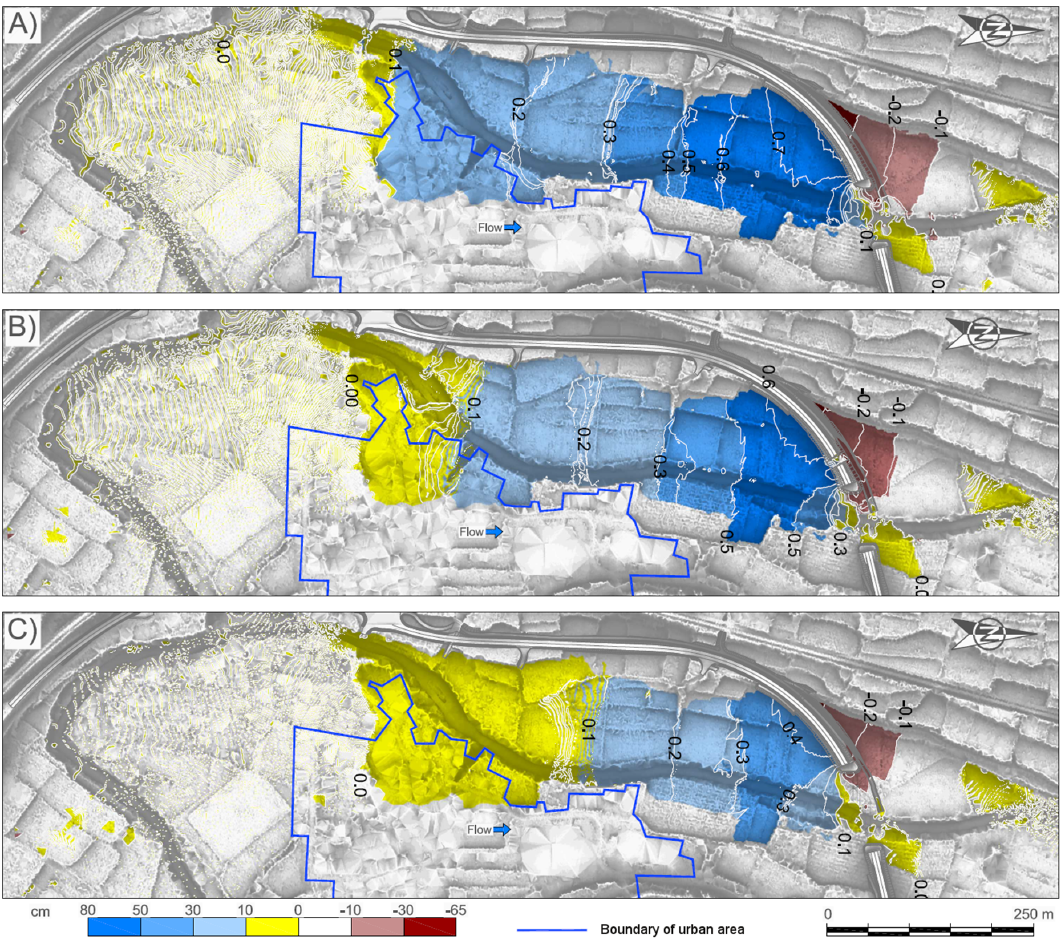
Figure 3. Comparative analysis of the water depth for the three options studied: ( A ) Option 1; ( B ) Option 2, and ( C ) Option 3. All of them show the variation in the water level produced by the execution of each option.